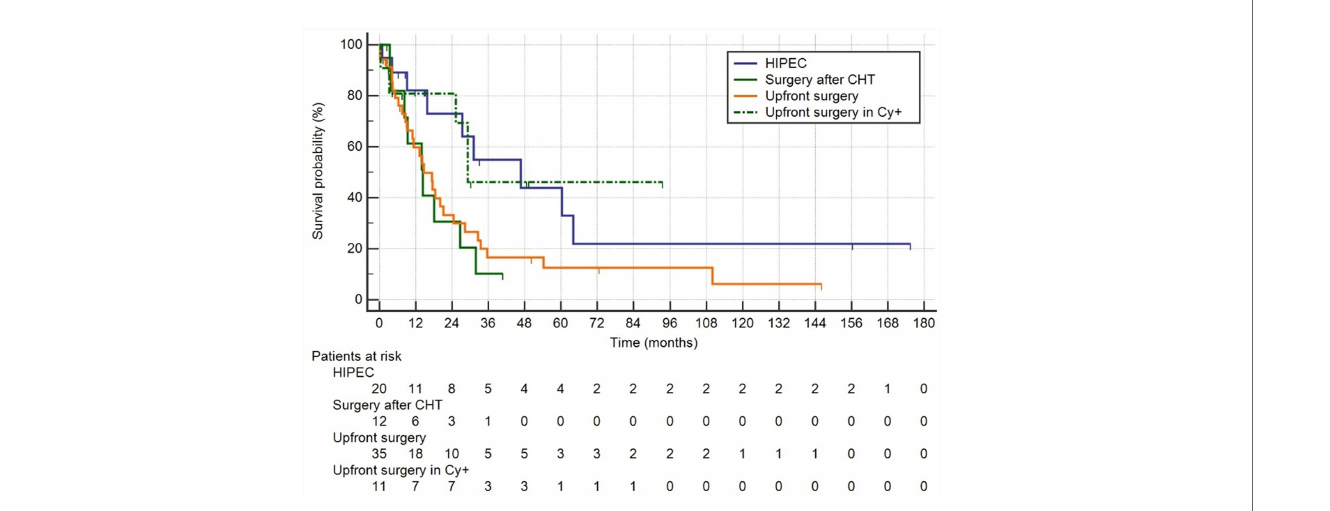
FIGURE 2 | Group1: HIPEC, palliative chemotherapy followed by surgery plus HIPEC; Group 2: surgery after CTH without HIPEC; Group 3: upfront surgery; Group 4: upfront surgery in positive Cy+ only.